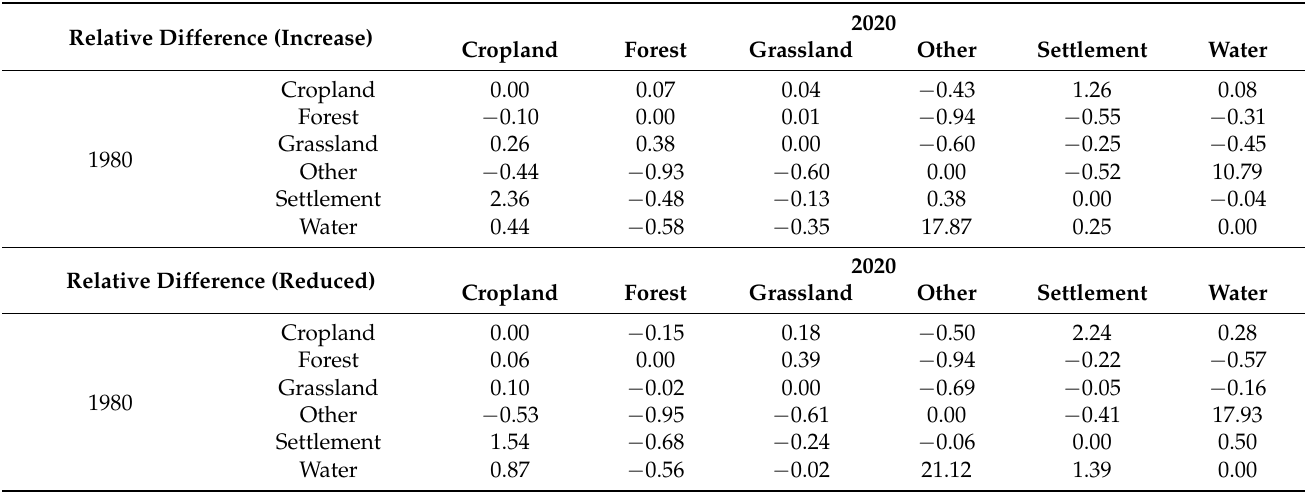
Table 3. Land transfer matrix of 1980–2020